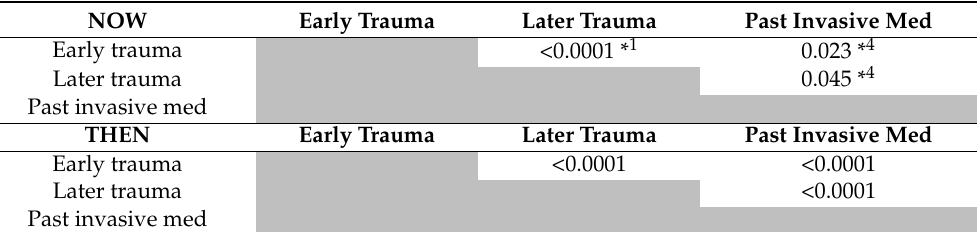
Table A4. Trauma.